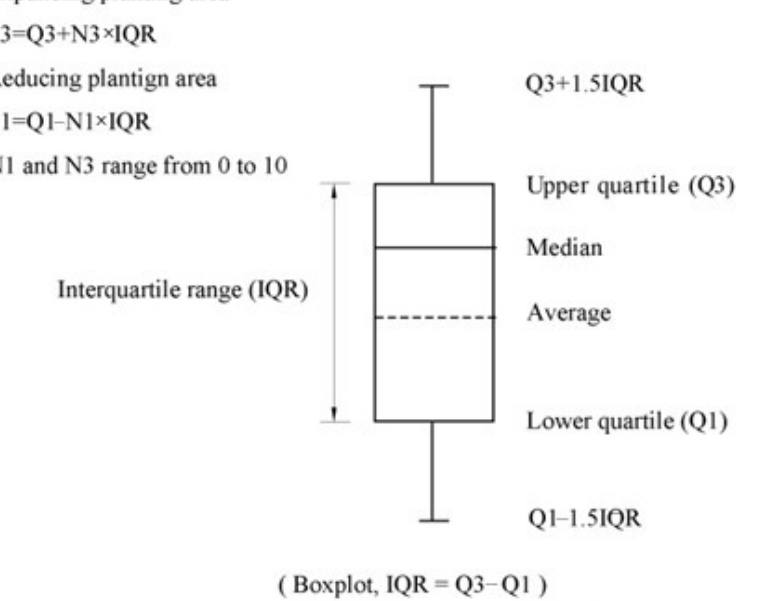
Figure 2. Method for planting structure adjustment. S3 and S1 represented crop planting areas after adjusting.